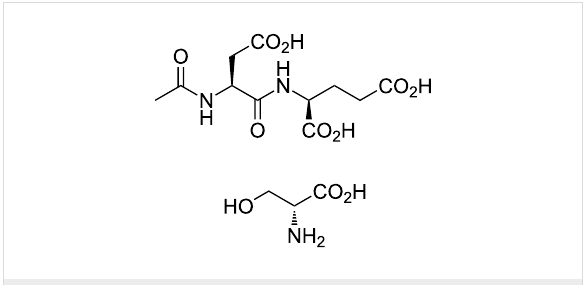
Figure 3: Neurotransmitters N -acetyl-aspartyl glutamate (NAAG, top) and D-serine (bottom).